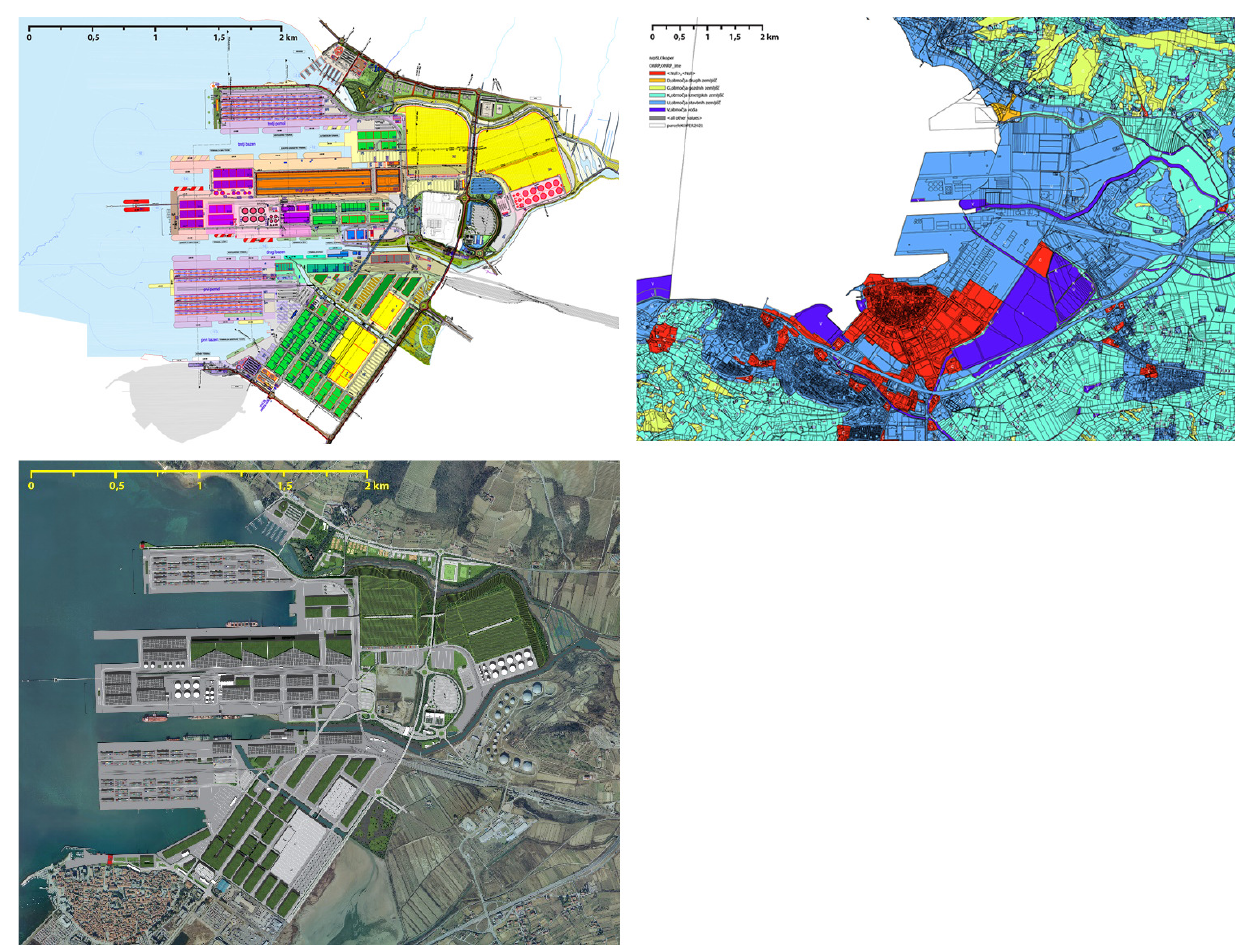
Figure 11. The port of Koper. (a) Professional guidelines for the master plan of the port of Koper with expected future development until 2030 (top left); (b) generalized planned land use database of the same area (top right); (c) orthophoto image of the future development (bottom). Sources: Ažman Momirski and Venturi (2010) and The Ministry of Environment and Spatial Planning of the Republic of Slovenia